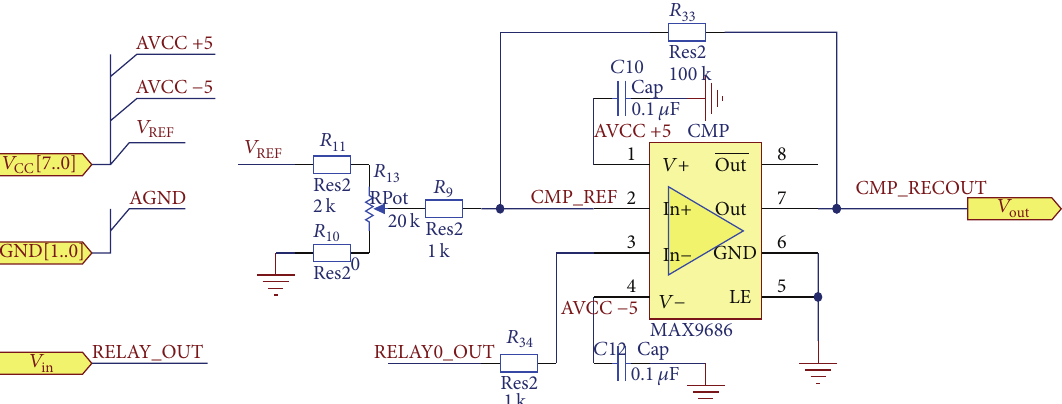
Figure 11: The circuit of generating square